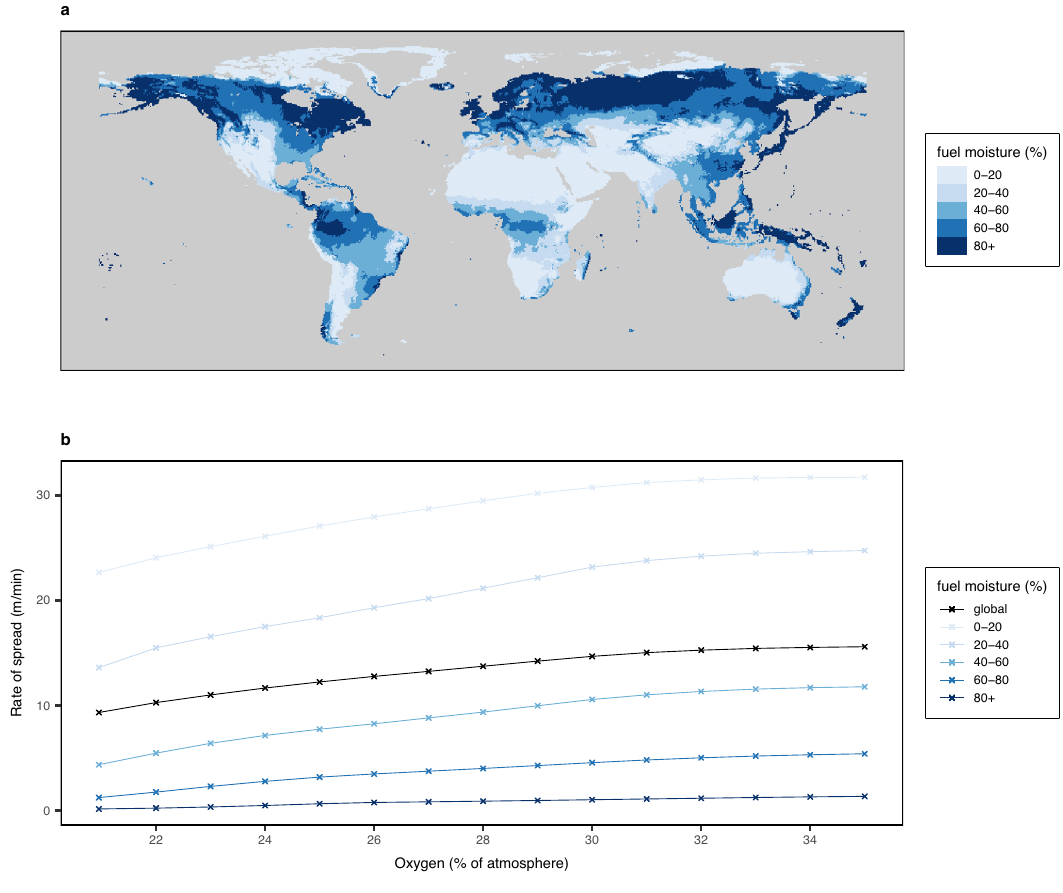
Fig. 4 | Global fuel moisture bands. Plots displaying global total fuel moisture contenttakenasa10-yearannualaverage fromthelastdecade of LPJ-LM fi reunder